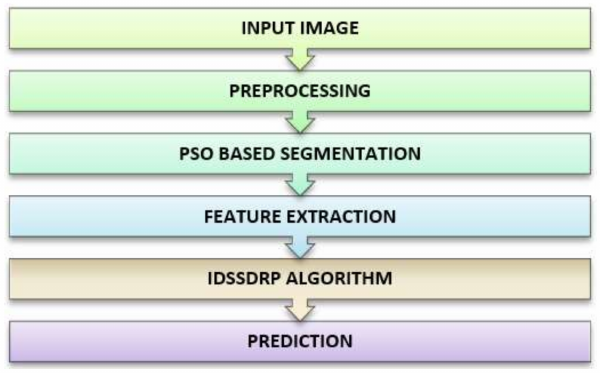
Figure 1. Proposed system